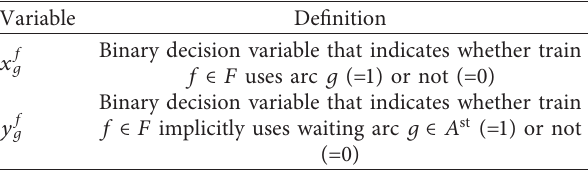
Table 3: Model decision